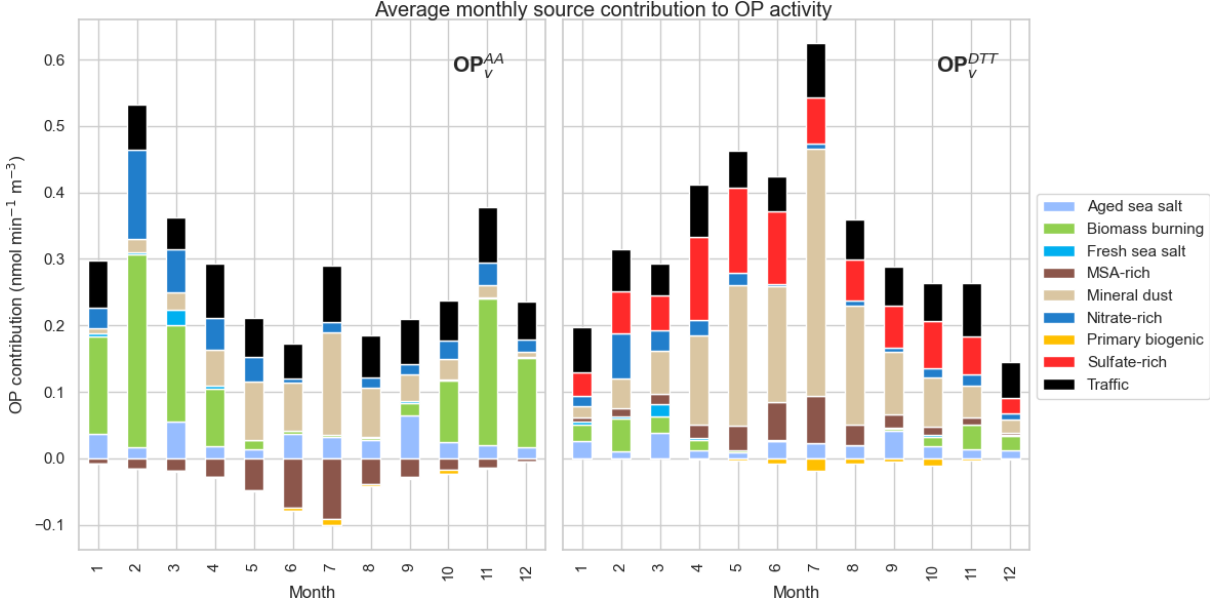
Figure 11. Monthly contribution of sources to OP activity in nmolmin − 1 m − 3 (OP DTT v and OP AA v ) from the year 2017 to 2020 at the OPE site. Note that the months are labelled from January (1) to December (12).